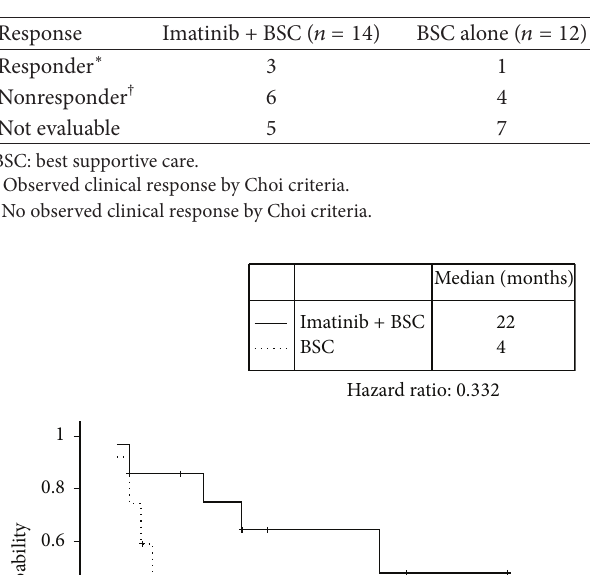
Table 2: Clinical response.